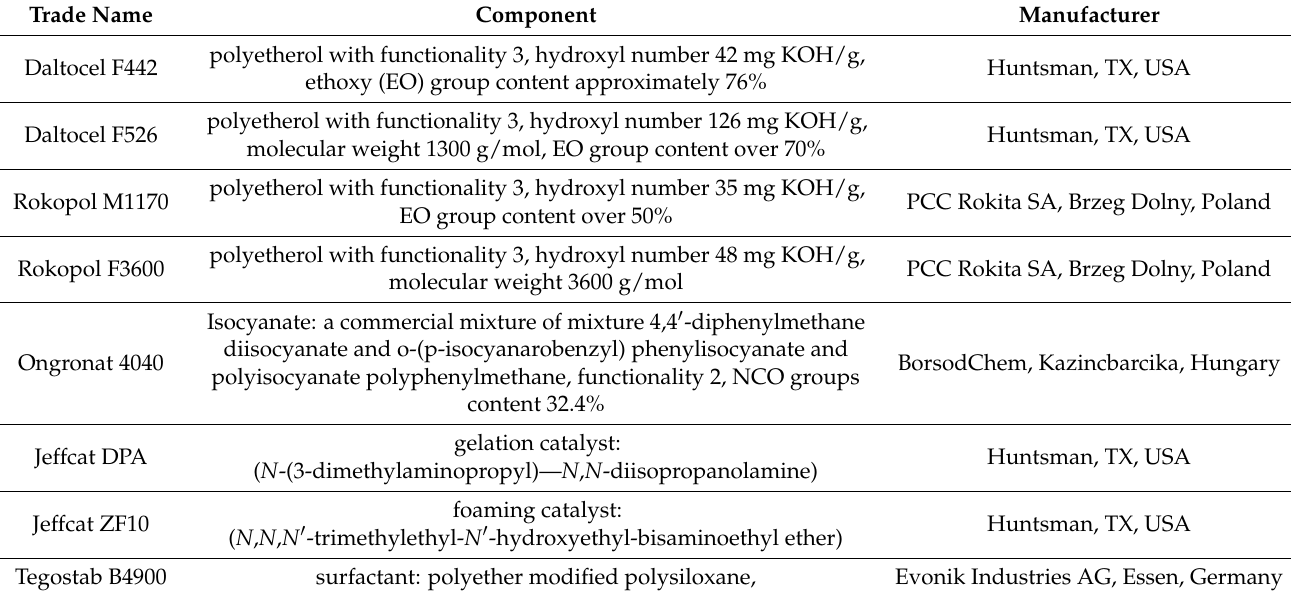
Table 1. The materials used to prepare the viscoelastic polyurethane foams